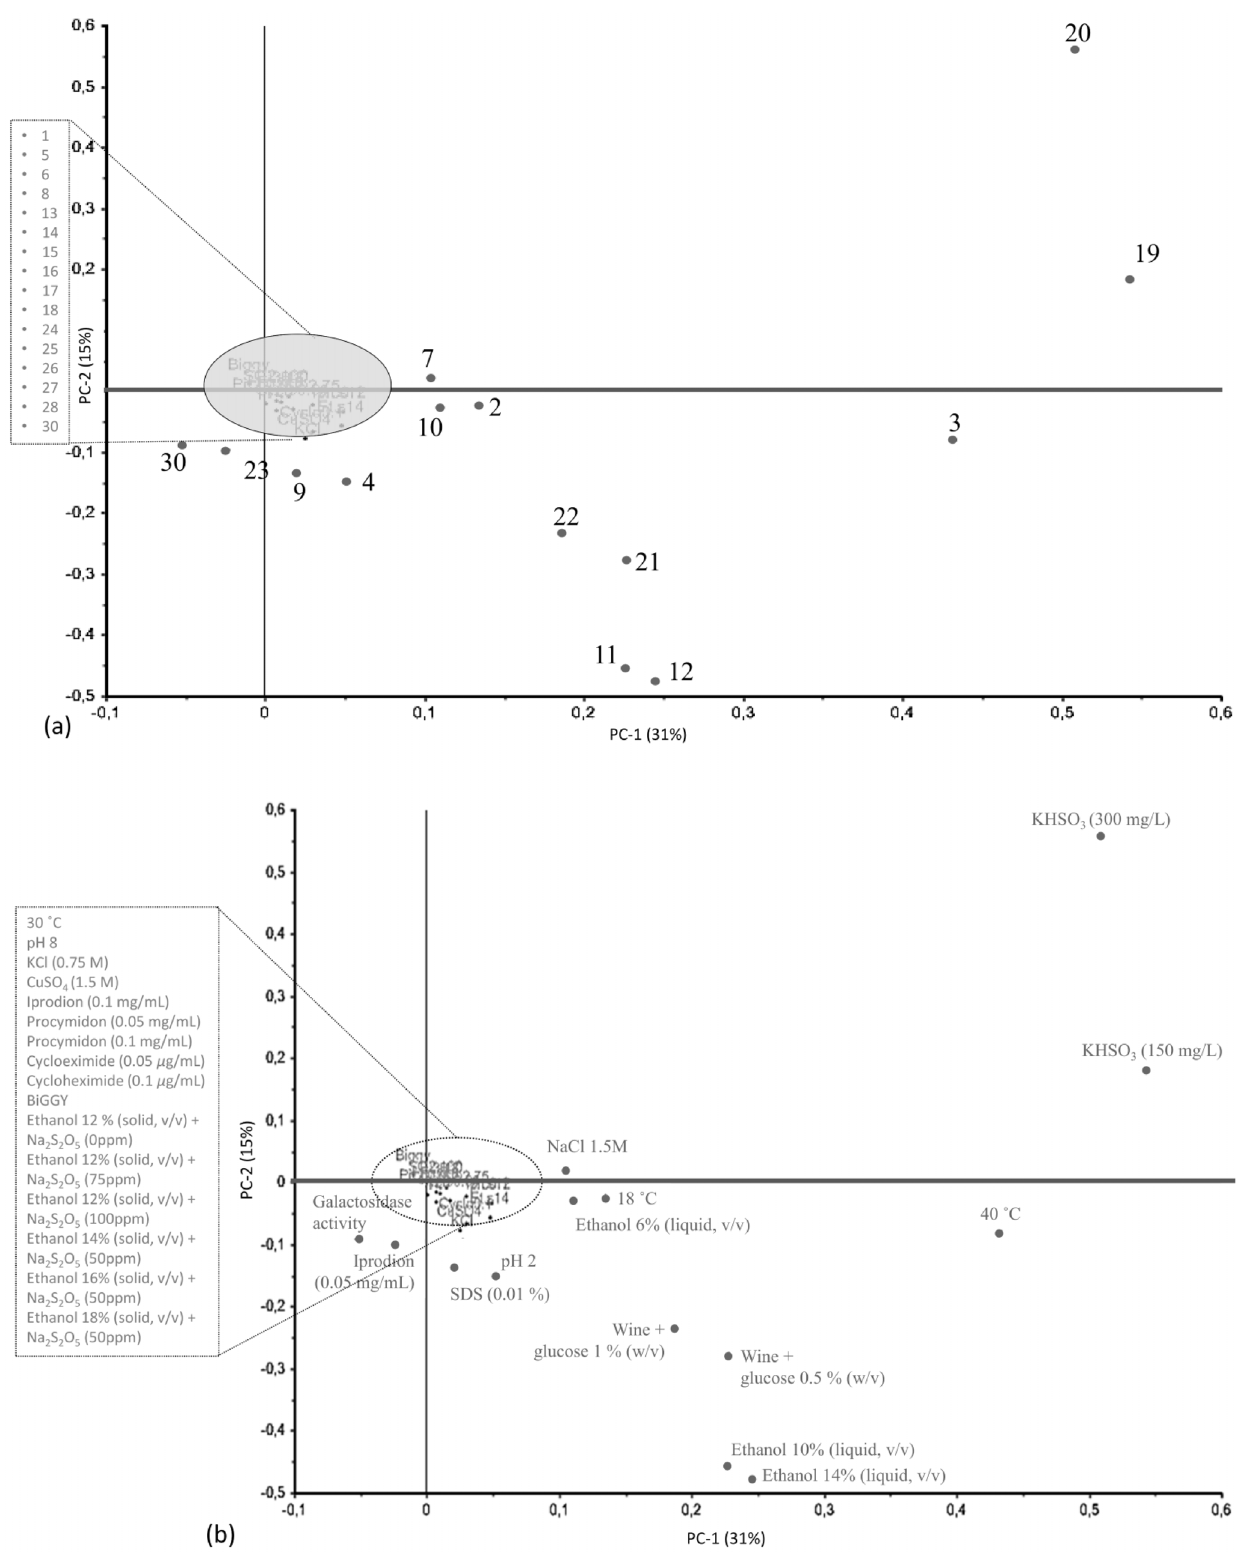
Figure 2. Principal component analysis of phenotypic data for 172 strains. ( a ) 2 30 phenotypic tests (loadings). Numbers indicate phenotypic tests, as mentioned in Table 1: (1) 2 30 u C; (2) 2 18 u C; (3) 2 40 u C; (4) – pH 2; (5) – pH 8; (6) – KCl (0.75 M); (7) – NaCl (1.5 M); (8) – CuSO 4 (1.5 M); (9) – SDS (0.01%); (10) – ethanol 6% (v/v) liquid medium; (11) – ethanol 10% (v/v) liquid medium; (12) – ethanol 14% (v/v) liquid medium; (13) – ethanol 12% (v/v) solid medium; (14) – ethanol 12% (v/v) solid medium + Na 2 S 2 O 5 (75 mg/L); (15) – ethanol 12% (v/v) solid medium + Na 2 S 2 O 5 (100 mg/L); (16) – ethanol 14% (v/v) solid medium + Na 2 S 2 O 5 (50 mg/L); (17) – ethanol 16% (v/v) solid medium + Na 2 S 2 O 5 (50 mg/L); (18) – ethanol